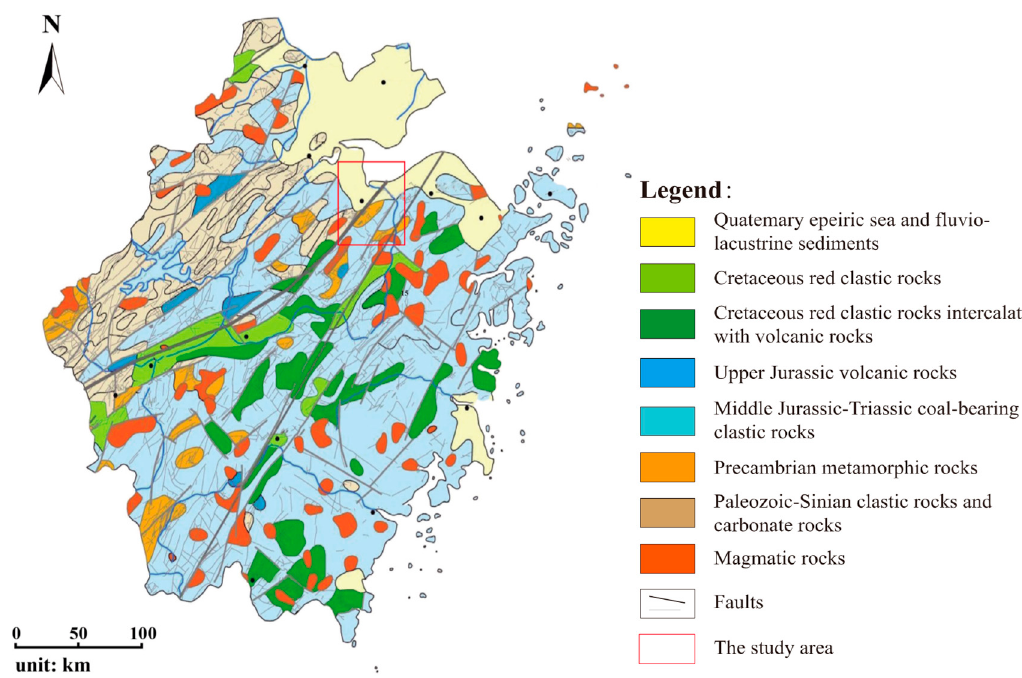
Figure 2. Schematic geological map of Zhejiang Province, China.